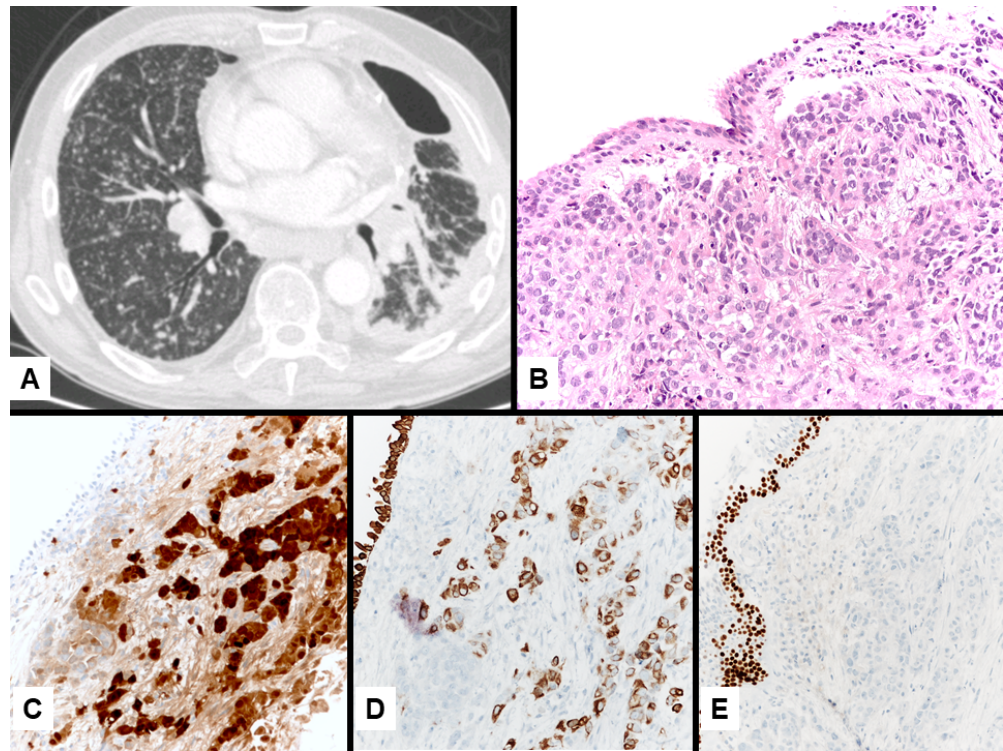
Figure 6. Epithelioid malignant mesothelioma of the left lung ( A ) diagnosed on a bronchial biopsy ( B ) infiltrated by a monomorphic epithelioid growth expressing calretinin ( C ) and CK5/6 ( D ), but not for p63 ( E ).